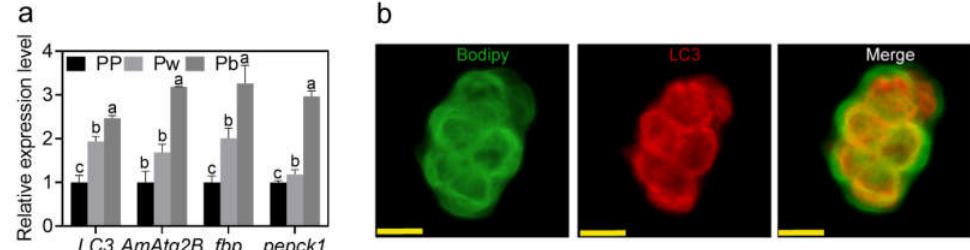
Figure 1. Lipophagy in the fat body of Apis mellifera pupae. ( a ) Fold changes of autophagy related genes ( LC3 and AmAtg2B ) and starvation-induced gluconeogenetic genes ( fructose-1,6-bisphosphatase ( fbp ) and Phosphoenolpyruvate carboxykinase 1 ( pepck1 )) in stage PP, Pw, and Pb. ( b ) Co-localization of LDs (green) with LC3 (red) in fat body cell of Pb. Scale bar: 5 μm. Note: Data are shown as mean ± SEM and the different letters marked on the bar chart represent significant differences ( p < 0.05).